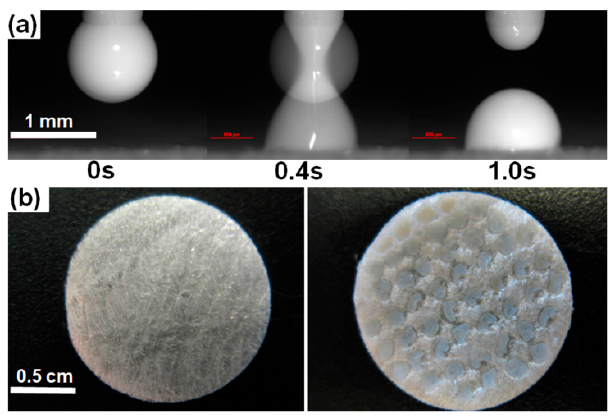
Figure 4. Printing 0.5-µL droplets of 2.5% HPMC-griseofulvin suspension onto 92%-porous HPMC film: ( a ) dispensing of a droplet, ( b ) 20.6-mg porous HPMC film before ( left ) and after ( right ) printing of fifty 0.5-µL droplets.